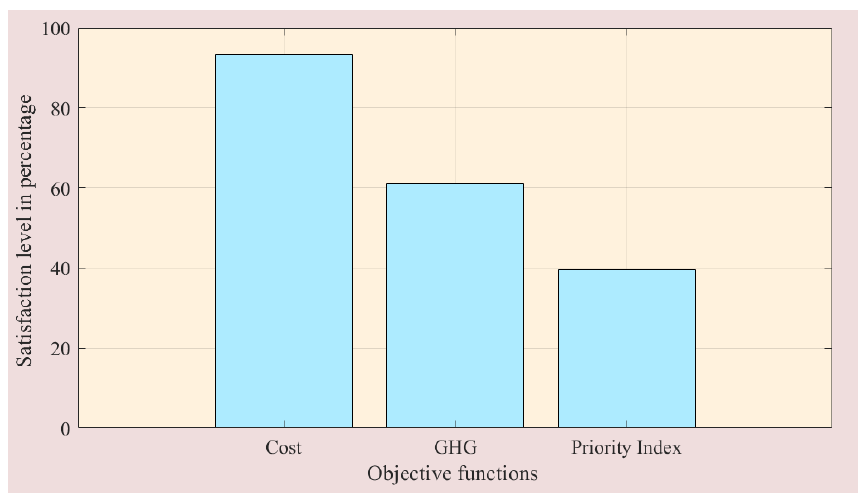
Figure 4. Satisfaction level of each objective.